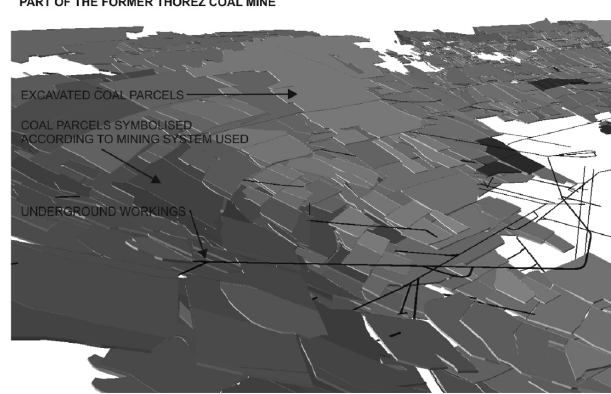
Figure 9. Three-dimensional visualisation of the selected under- ground workings and coal parcels classified according to the mining system